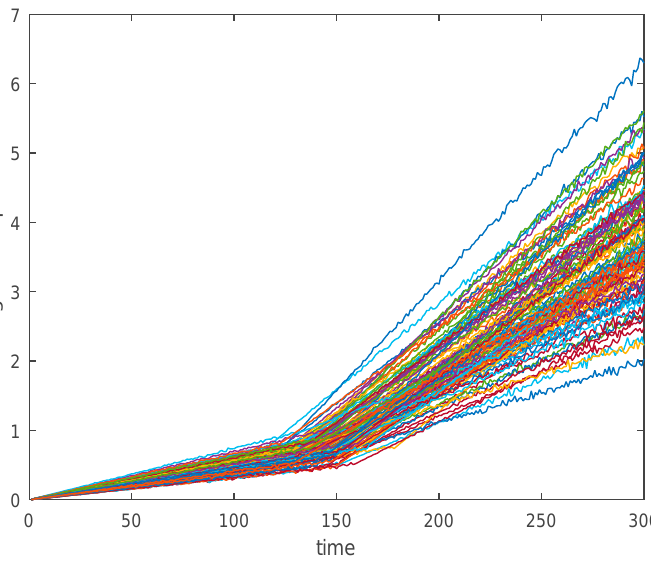
Figure 3. One hundred sets of two-phase degradation data created by a computer.